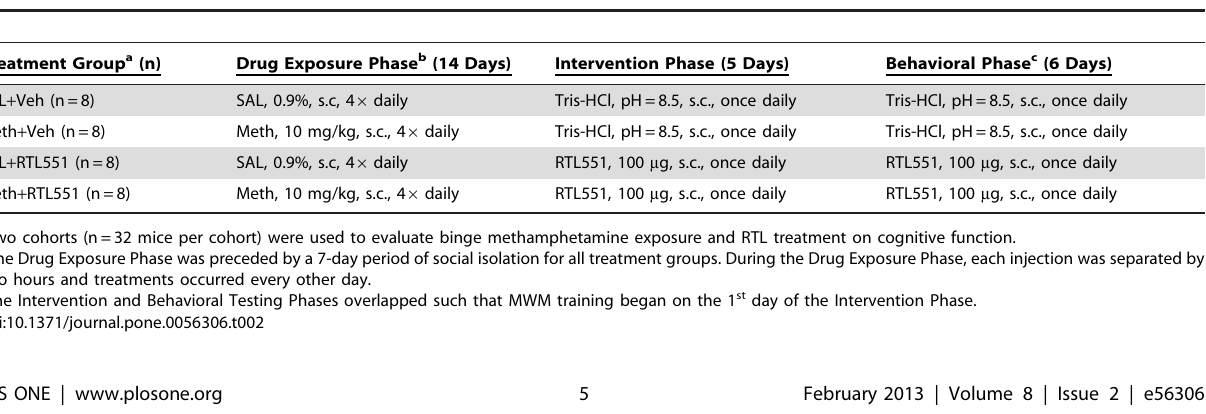
Table 2. Study Design: Evaluation of binge methamphetamine exposure and RTL treatment on cognitive function.